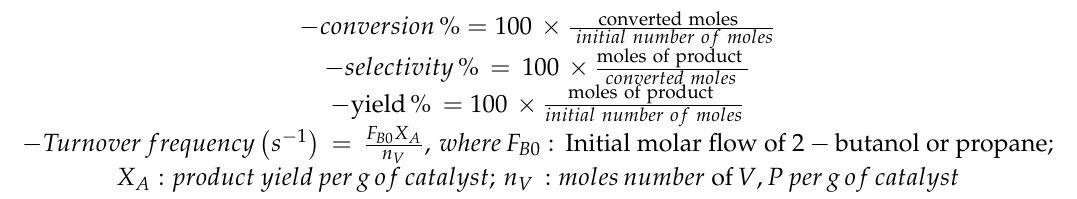
for ZrO 2 ; Figure S2: N 2 adsorption/desorption isotherms for 3.6 wt%V 2 O 5 /ZrO 2 powder; Figure S3: N 2 adsorption/desorption isotherms for P loaded 3.6 wt%V 2 O 5 /ZrO 2 at P/V = 0.5; Figure S4: N 2